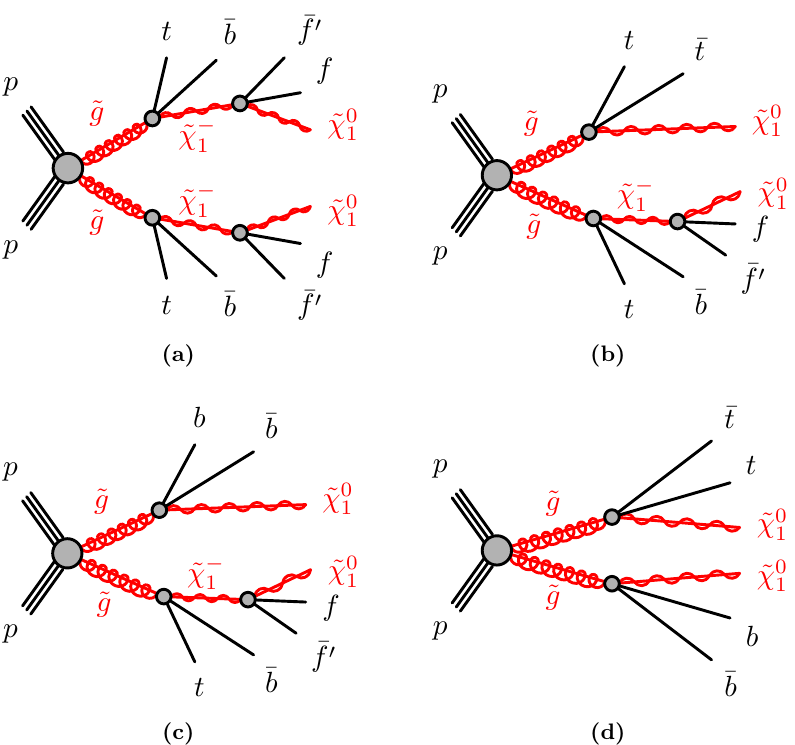
Figure 2. The additional decay topologies of the variable gluino branching ratio model in addition to the ones of (cid:12)gure 1. (a) Both gluinos can decay as ~ g ! t (cid:22) b ~ (cid:31) (cid:0) 1 with ~ (cid:31) (cid:0) 1 ! f (cid:22) f 0 ~ (cid:31) 0 1 , or only one can with the other decaying as (b) ~ g ! t (cid:22) t ~ (cid:31) 0 1 or (c) ~ g ! b (cid:22) b ~ (cid:31) 0 1 . (d) Finally, one gluino can decay as ~ g ! t (cid:22) t ~ (cid:31) 0 1 and the other as ~ g ! b (cid:22) b ~ (cid:31) 0 1 . The charge conjugate processes are implied. The fermions originating from the ~ (cid:31) (cid:6) 1 decay are typically soft because the mass di(cid:11)erence between the ~ (cid:31) (cid:6) 1 and the ~ (cid:31) 0 1 is (cid:12)xed to 2